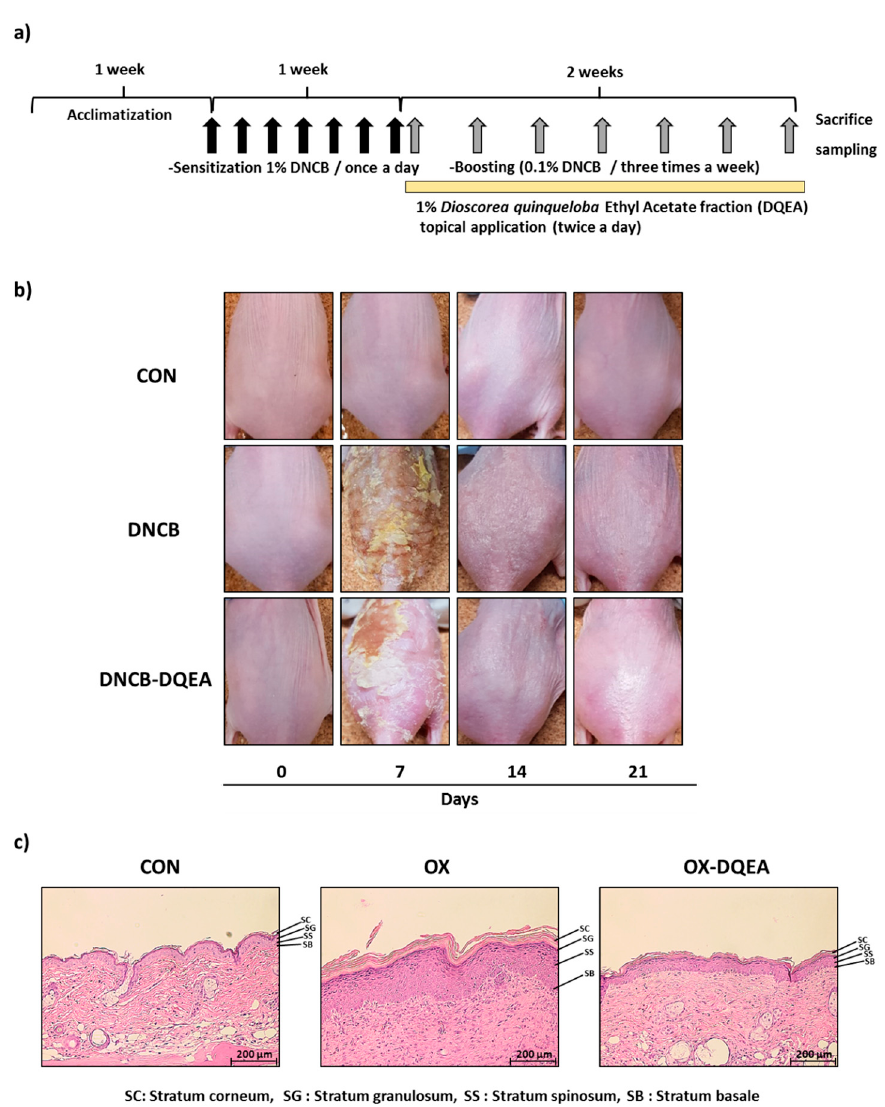
Figure 3. Effects of DQEA on the development of DNCB-induced AD-like symptoms in hairless mice and histopathological analysis. CON: control group, DNCB: DNCB-treated group,